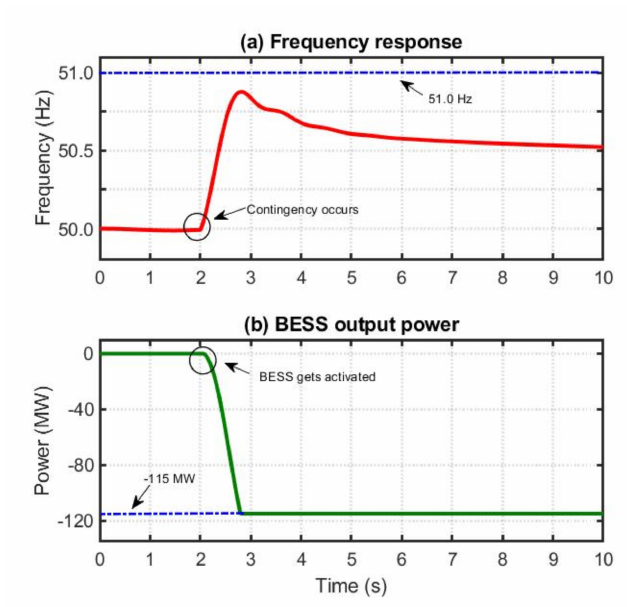
Figure 12. FrequencyresponsesandBESSoutputdueto450-MWinterconnectiontripinfour-machinecase.